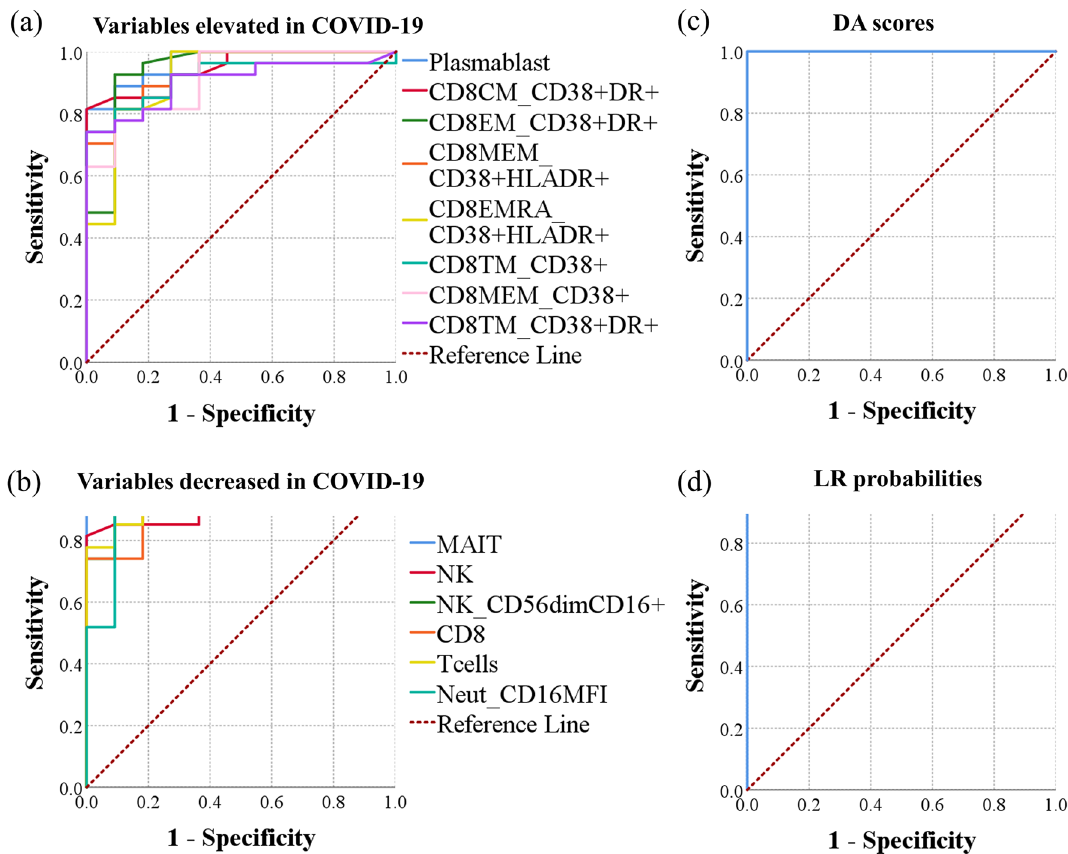
Figure 3. Evaluation of individual predictors, discriminant scores, and binary logistic regression probabilities as biomarkers of COVID-19 among a group of patients and normal controls. ROC curves were generated using data from healthy control participants (n = 12) and patients with moderate or severe disease (n = 34). ROC curves of ( a ) individual analytes elevated in COVID-19, ( b ) individual analytes decreased in COVID-19, ( c ) discriminant function scores, and ( d ) probabilities of having COVID-19 computed using binary logistic regression are